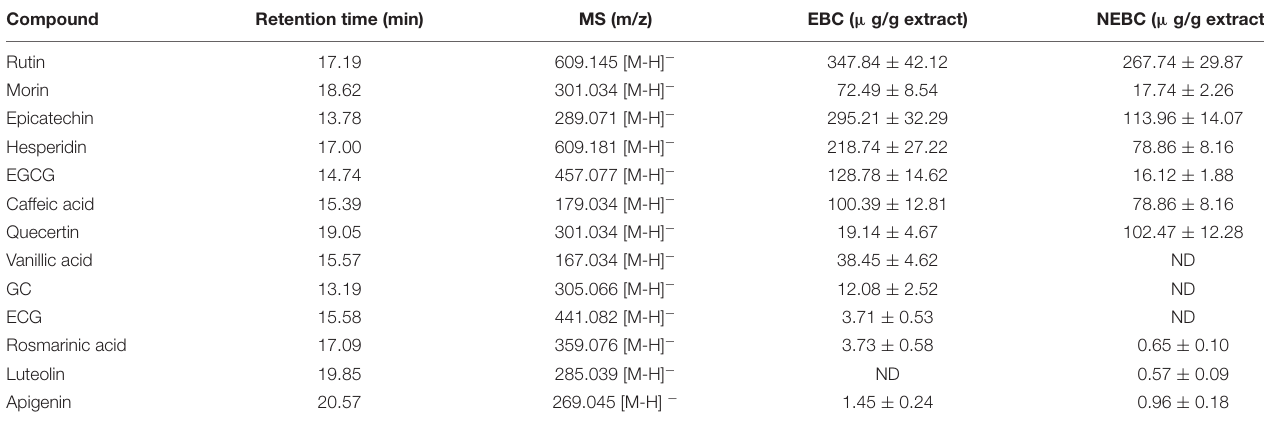
( Figure 2D ). Overview, our results illustrated that EBCs and NEBCs potently reduced the viability of colon cancer cells, whereas there were no cytotoxicity effects on the normal colon cells at higher concentrations. Furthermore, EBCs displayed stronger inhibitory effects on the growth of colon cancer cells, compared with the NEBCs. Thus, we selected EBCs, at 50 and 100 µ g/ml, and NEBCs, at 200 and 300 µ g/ml, according to the results of the MTT assay, for the further mechanistic test.